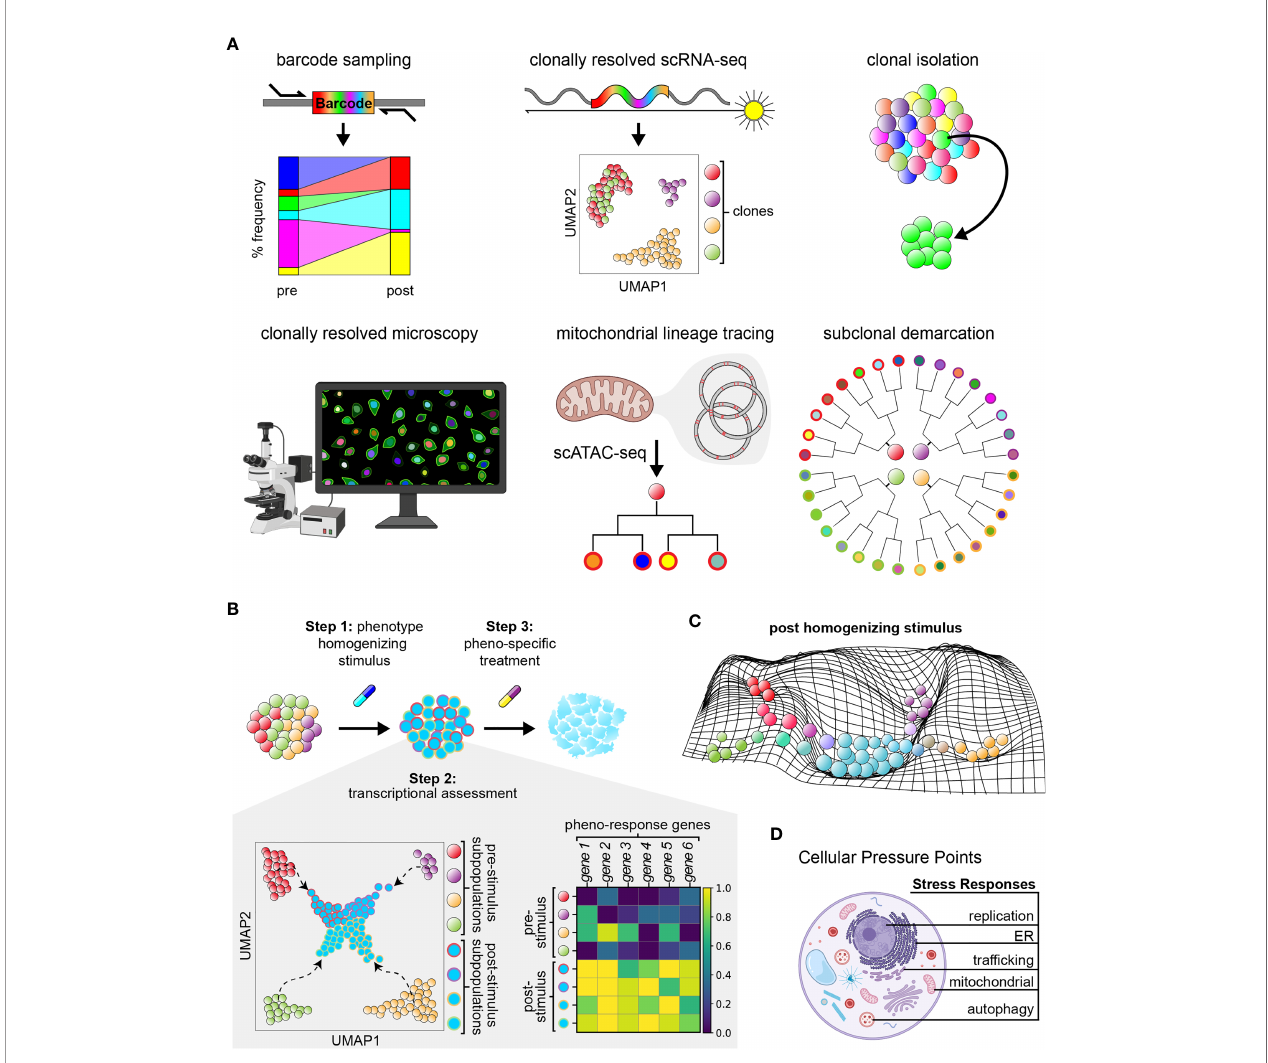
FIGURE 2 | Functionalized lineage tracing can enable phenotypic homogenization. (A) Current features of multi-functionalized lineage tracing approaches. (B) Three – step model of phenotypic homogenization. Step 2 includes example uniform manifold approximations and projections (UMAP) of subpopulations within a cancer cell population prior to and after subjection to a phenotype homogenizing stimulus, as well as the corresponding matrix plot of differential gene expression data. Colors within the UMAP correspond to different cell states. Homogenized cells are outlined by colors representing their cell state of origin prior to treatment. Colors within the matrix plot represent the relative fold expression of each gene; yellow represents upregulation and dark blue represents downregulation of genes. Homogenized populations exhibit consistent upregulation of the same genes. (C) Example manifold depicting the phenotypic landscape of a cancer cell population shortly after treatment with a phenotype homogenizing stimulus. Cells of different cell state origins are pressured to adopt a new, more common phenotype. (D) Illustration of cellular stress responses of interest to target for achieving phenotypic